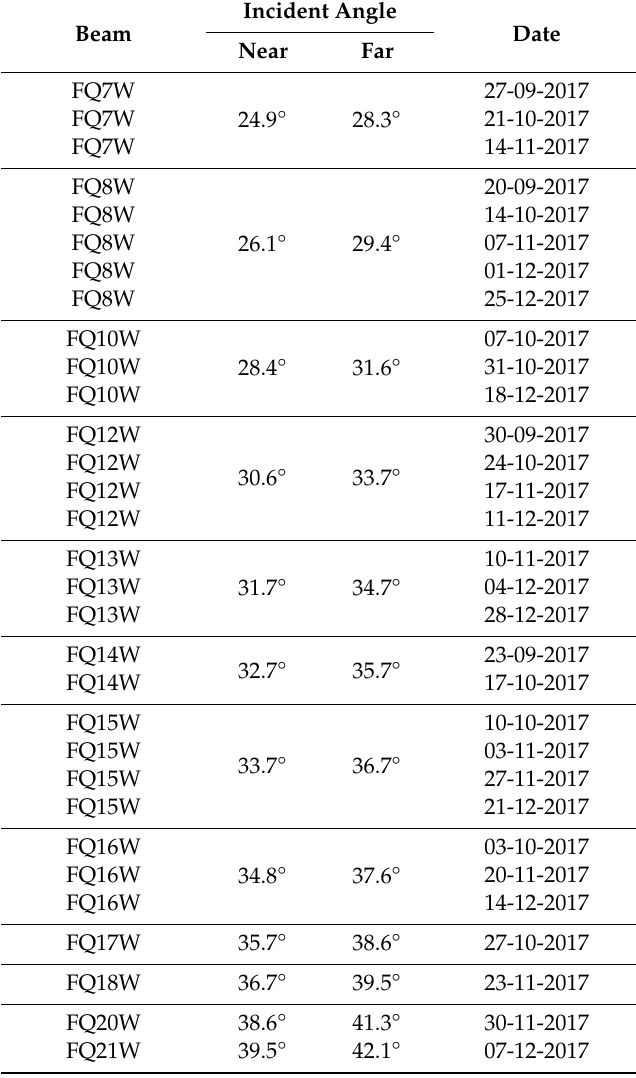
Table 1. A list of the RADARSAT-2 acquisitions sorted by imaging beam